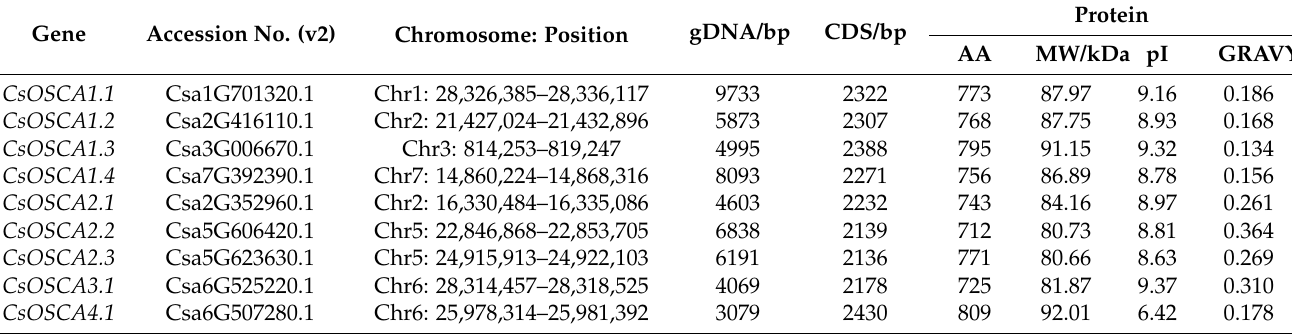
Table 1. Identification and characterization of OSCA gene family in